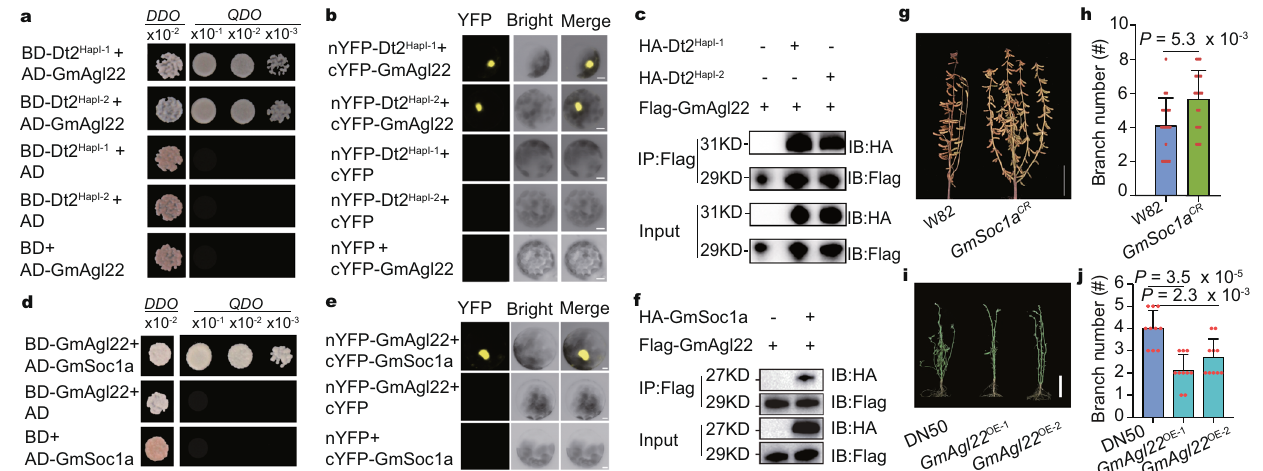
Fig. 3 | Dt2, GmAgl22 and GmSoc1a could interact with each other and affect the branch number. a Interaction between Dt2 and GmAgl22 in the yeast two- hybrid assay. Transformed yeast cells are grown on DDO (Trp/Leu) or QDO (Trp/ Leu/His/Ade) synthetic dropout medium. The number at the top indicates three serial dilutions. AD, GAL4 activation domain; BD, GAL4 DNA-binding domain. b BiFC analysis of the interaction between Dt2 and GmAgl22. Scale bars, 10mm. cYFPC-terminalportion of YFP.nYFP N-terminalportion of YFP. c Co-IP analysis of the protein interactions between Dt2 and GmAgl22. Flag-tagged GmAgl22 is co- transformed with HA-tagged Dt2 into Arabidopsis protoplasts. d Interaction betweenGmSoc1aandGmAgl22intheyeasttwo-hybridassay. e BiFCanalysisofthe interaction between GmSoc1a and GmAgl22. Scale bars, 10mm. f Co-IP analysis of